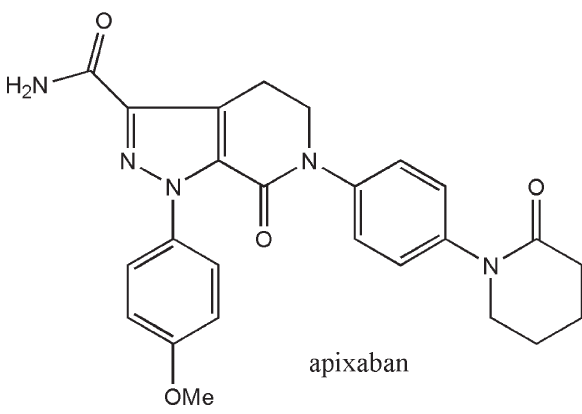
Figure 2: Chemical structure of